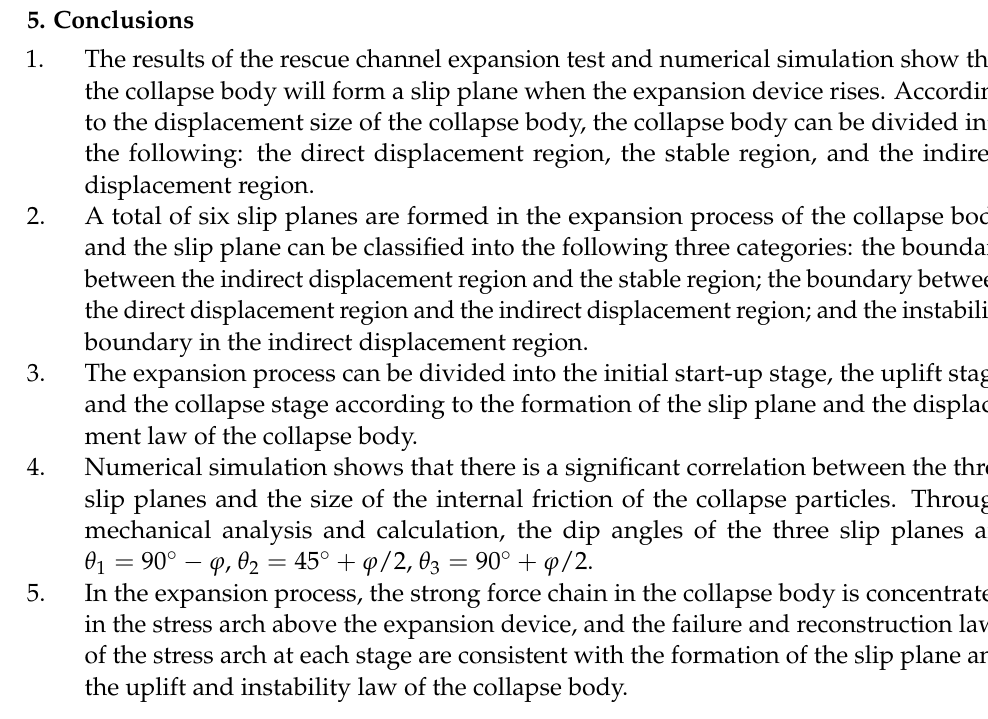
Figure 15. Variation curve of potential energy–kinetic energy.